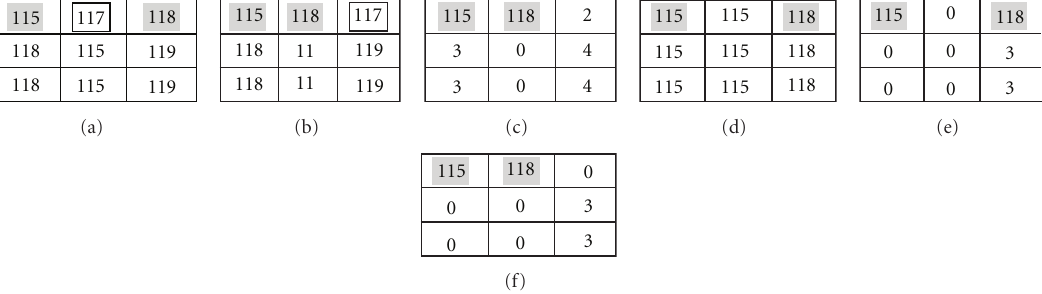
Then treat the n 2 -3 digit